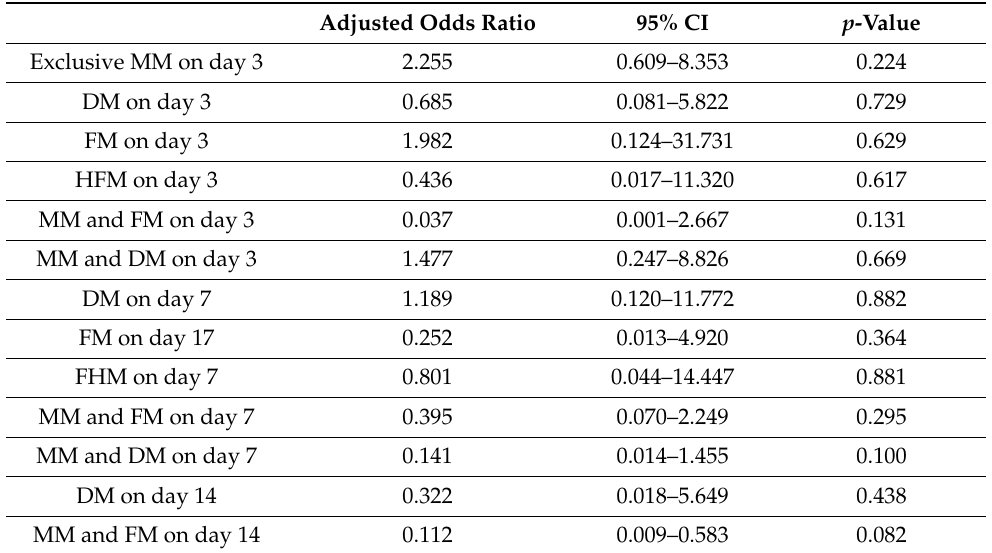
Table A4. Relationship between feeding strategies and NEC adjusted for demographic variables: results from Logistic regression model on days 3, 7, and 14